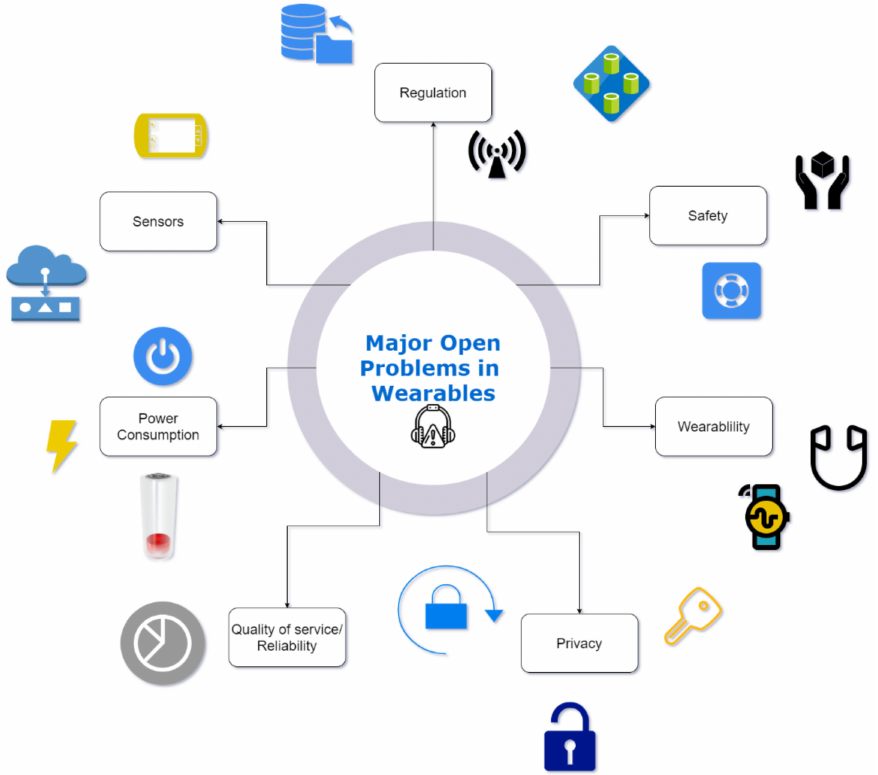
Figure 13. Open problems—IoT-assisted wearable sensor systems in